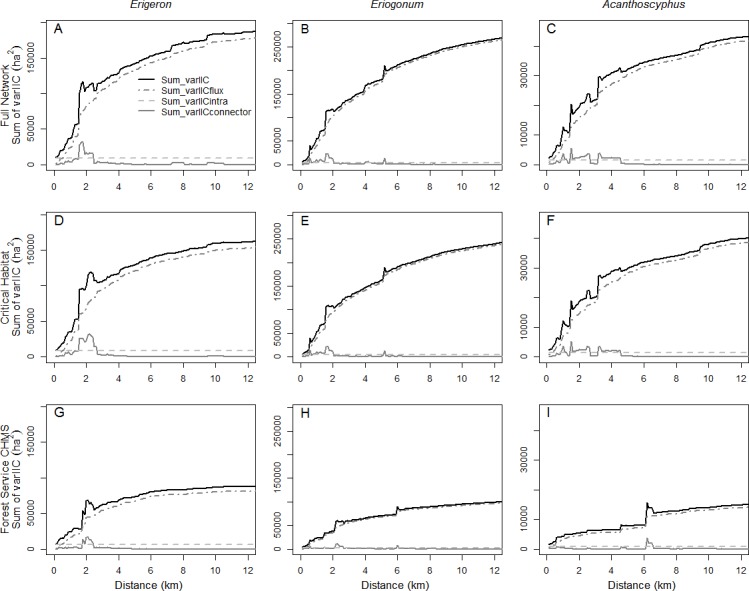
Absolute contributions of intrapatch area, flux, and connector fractions of connectivity.Values of total sum_varIIC and absolute values of sum_varIICintra, sum_varIICflux, and sum_varIICconnector, for the full network (A–C), critical habitat (D–F), and the Forest Service’s carbonate habitat management strategy (G–I) for Erigeron parishii (A, D, G), Eriogonum ovalifolium var. vineum, (B, E, H) and Acanthoscyphus parishii var. goodmaniana (C, F, I). Note that the y-axis values differ among species.